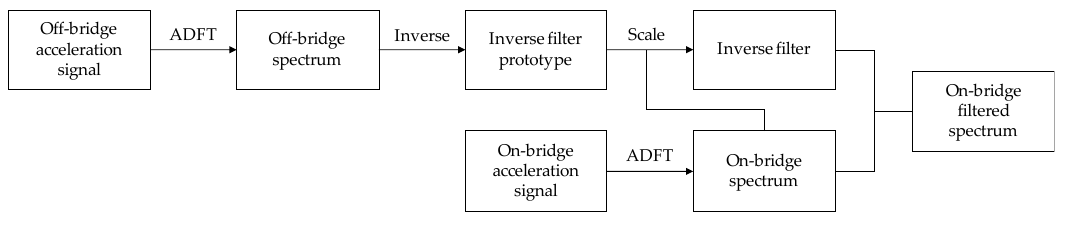
Figure 5. Flowchart of the proposed inverse filtering methodology.